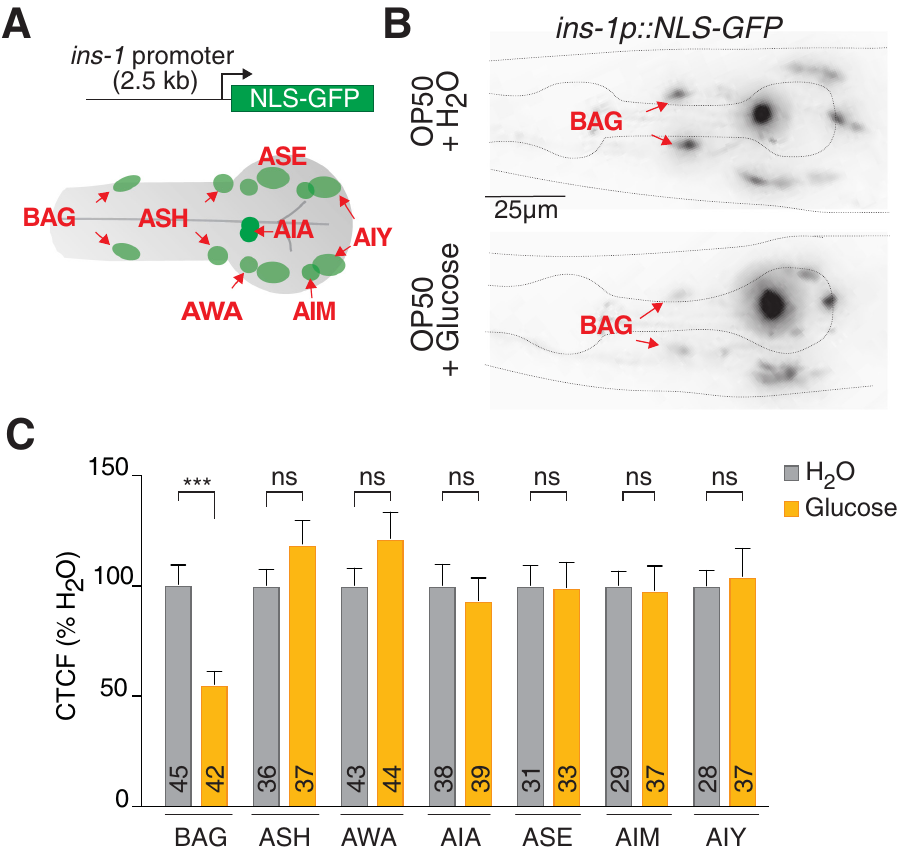
Fig 1. A high glucose diet down-regulates ins-1 promoter activity in the BAG neurons. AU : AbbreviationlisthavebeencompiledforthoseusedinFigs 1 (cid:0) 7 andS 1 (cid:0) S 6 : Pleaseverifythatallentriesarecorrect : (A) A 2.5-kb fragment of the ins-1 promoter drives expression in > 10 neurons. (B) Representative images of ins-1p :: NLS-GFP expression in E . coli OP50-fed (upper panel) and E . coli OP50 + 40 mM glucose-fed (lower panel) animals (BAG neurons indicated by red arrows). Diet treatment: 24 hours. Scale bar 25 μ m. (C) Quantification of nuclear GFP intensity across all observable neurons of the ins-1p :: NLS-GFP reporter grown on E . coli OP50 or E . coli OP50 + 40 mM glucose. Diet treatment: 24 hours. Data presented as CTCF % of no glucose, � x + SEM, n shown within bars, ns, not significant ( p > 0.05), ��� = p � 0.001, significance assessed by unpaired t test. The underlying numerical data can be found in S1 Data. CTCF, calculated total fluorescence; GFP, green fluorescent